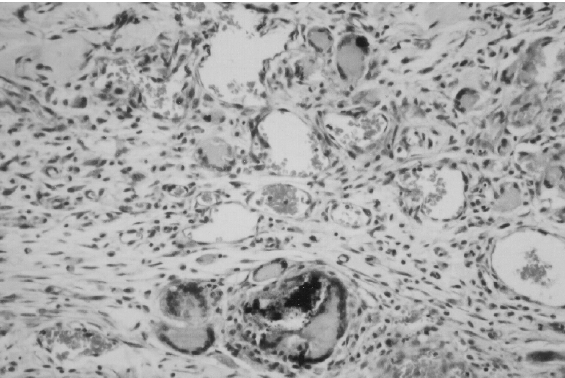
FIGURA 5- Sealapex – 45 dias: infiltrado inflamatório difuso. Evolução por colagenização Atividade macrofágica sobre o material extravasado. HE Nikon 80x